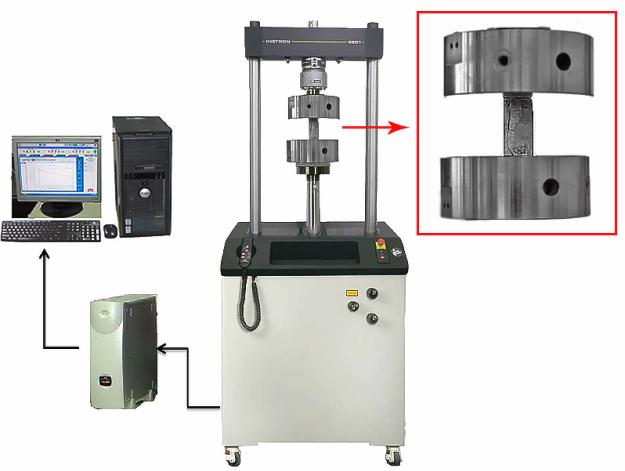
Figure 5. Experimental apparatus for compressive stress test (close up shows a fractured sample).